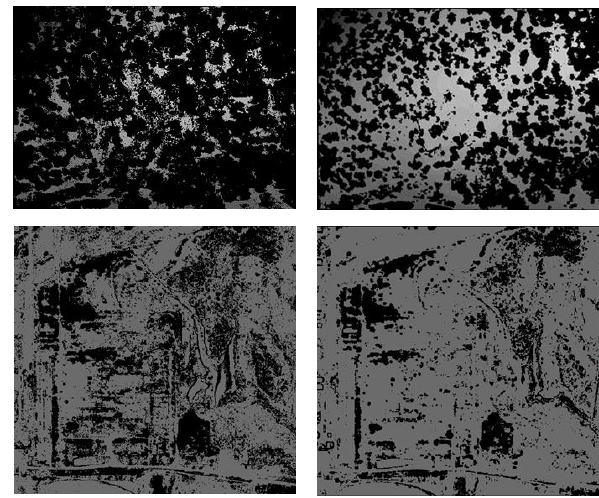
Figure 11 : Initial mask with NDVI threshold 0.09 (left) and final mask after morphological filtering (right) for Kimisala (top) and Vasiliko (bottom)